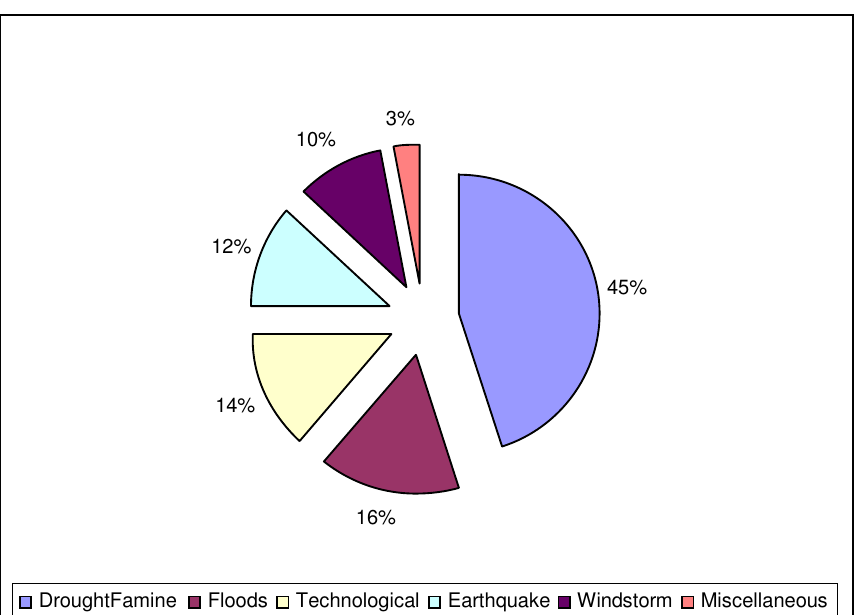
Figure 4. Reported Deaths from all Disasters: World Scenario